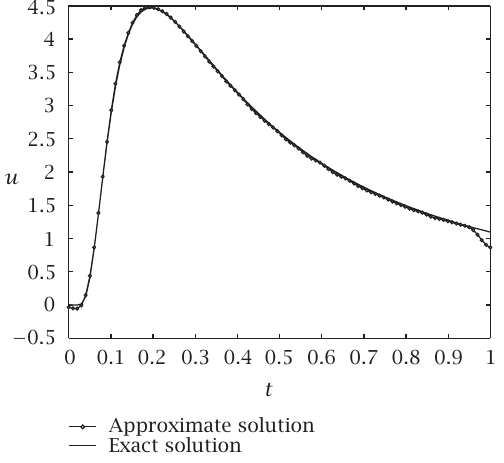
. = . = 3, α 0 4 . 0 × 10 − 6 (by formula